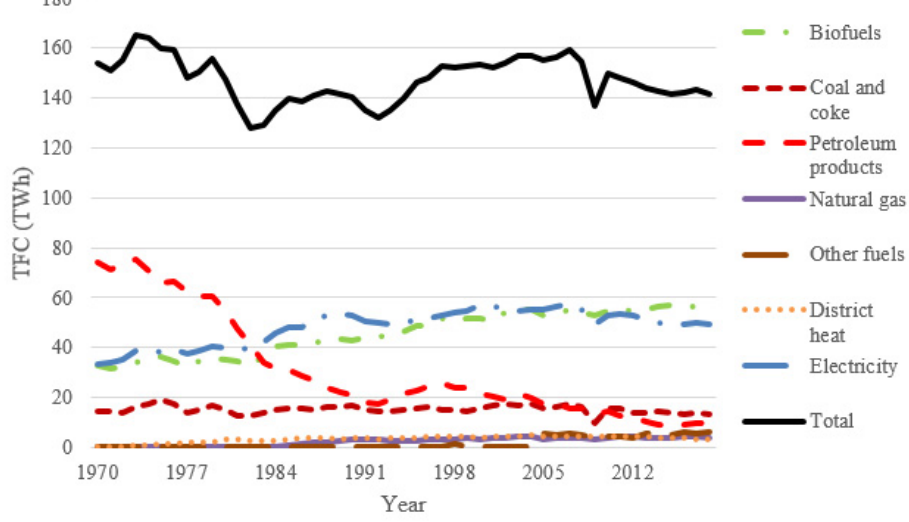
Figure 2. TFC in industrial sectors by energy type. Source: Swedish Energy Agency [41].